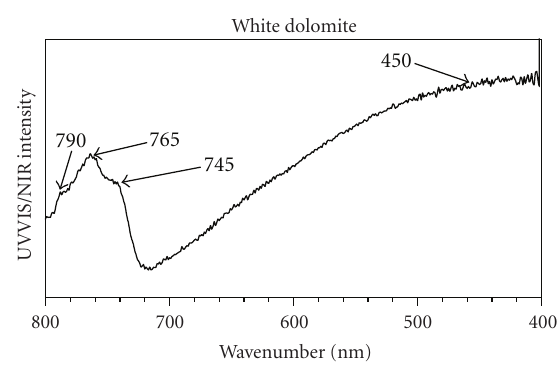
Figure 4: Optical absorption spectrum of white dolomite at room